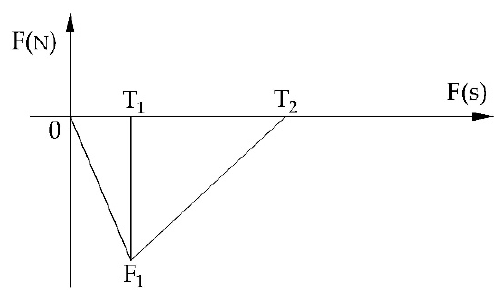
Figure 2. Equivalent triangular waveform of the impact load. Table 3. The impact force and stress corresponding to the falling height.